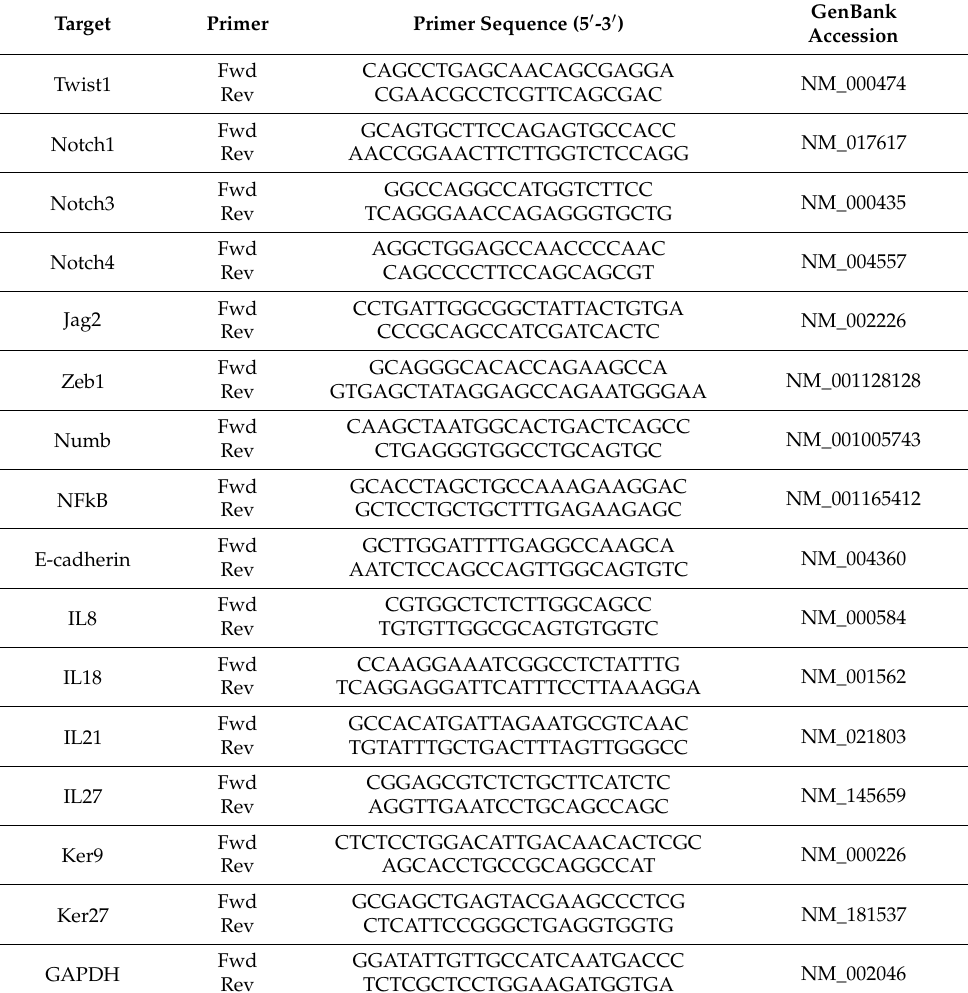
Table 1. List of primers used in the present